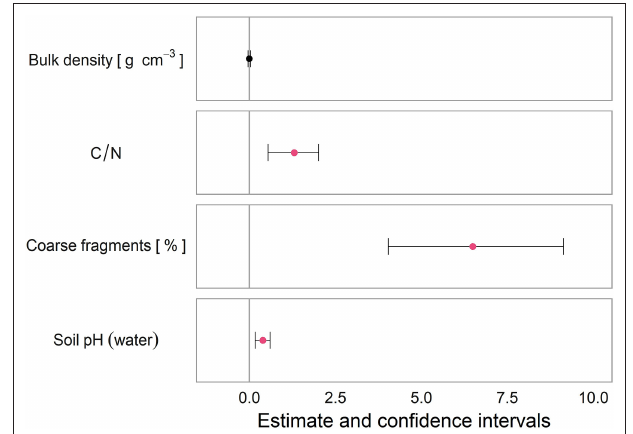
FIGURE 3 | Estimated fixed effects of model coefficients and 95% confidence intervals (CI) of the linear mixed models for bulk density, C/N ratio, coarse fragment content and soil pH (water), which compares the two urban soil strata. Error bars that do not cross the zero line indicate statistical significance.